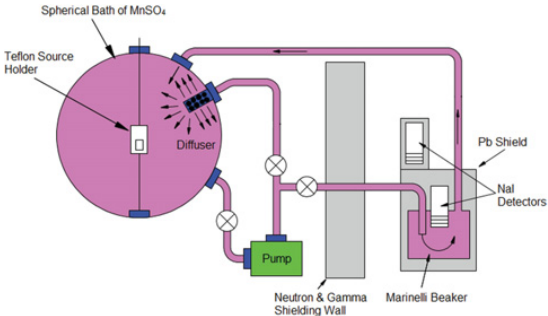
Figure 6. Schematic of the manganese bath including the shielded detector and pumping